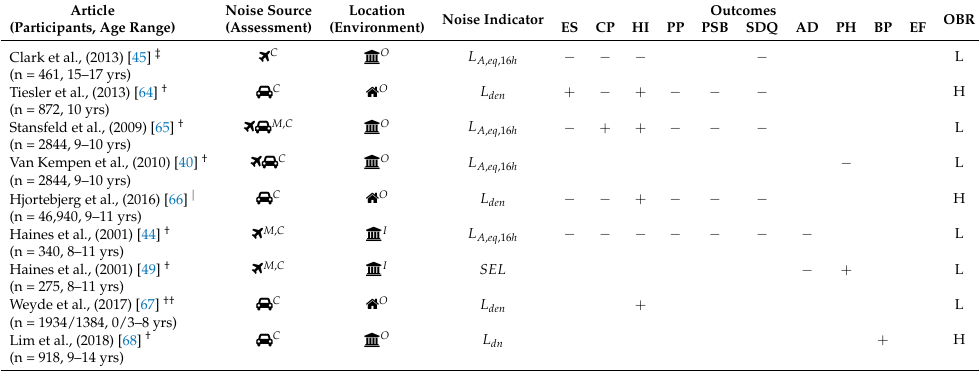
Table 10. Mental health effects-based studies. SDQ corresponds to the total score of the psychological morbidity SDQ test. ES corresponds to emotional symptoms, CP to conduct problems, HI to hyperac- tivity/inattention, PP to peer problems, PSB to pro-social behavior problems (SDQ sub-scales). AD to anxiety/depression, PH to perceived general and mental health, BP to behavioral problems, and EF to executive functioning skills. For explanation of symbols and notations, see caption of Table